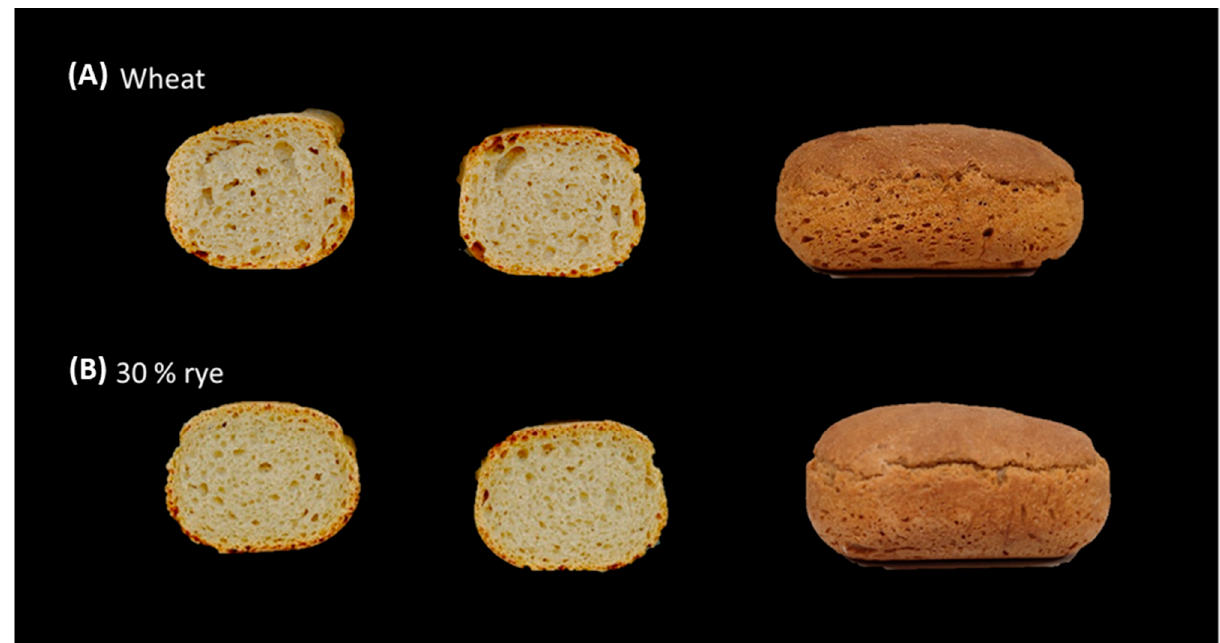
Figure 5. Dough development ( A ) and gas production ( B ) of doughs prepared from wheat flour (black line) and rye-wheat blend (30:70) (grey line). In panel B, solid lines refer to produced gas, whereas dotted lines refer to retained gas in the dough.